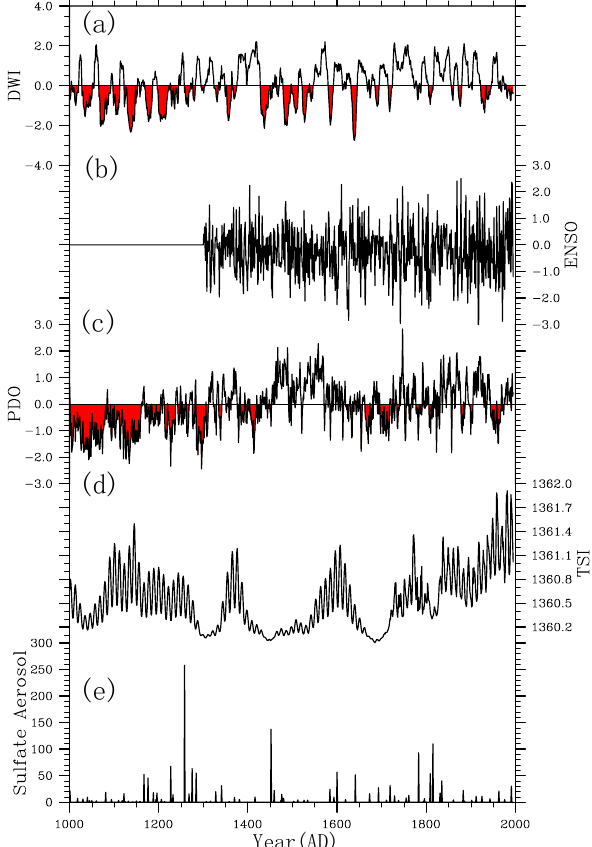
Figure 3. Climate records during the last millennium. (a) DWI from Zheng et al. (2006) over eastern China. The area between the black line and zero is colored red for the region below zero. (b) Tree-ring- based Niño3.4 SSTs from Li et al. (2013). (c) Tree-ring-based PDO reconstruction from MacDonald and Case (2005). The area between the black line and zero is colored red for the region below zero. (d) The solar forcing of total solar irradiance (Wm − 2 ) from Vieria et al. (2011). (e) The volcanic forcing of global sulfate aerosol (Tg) from Gao et al.